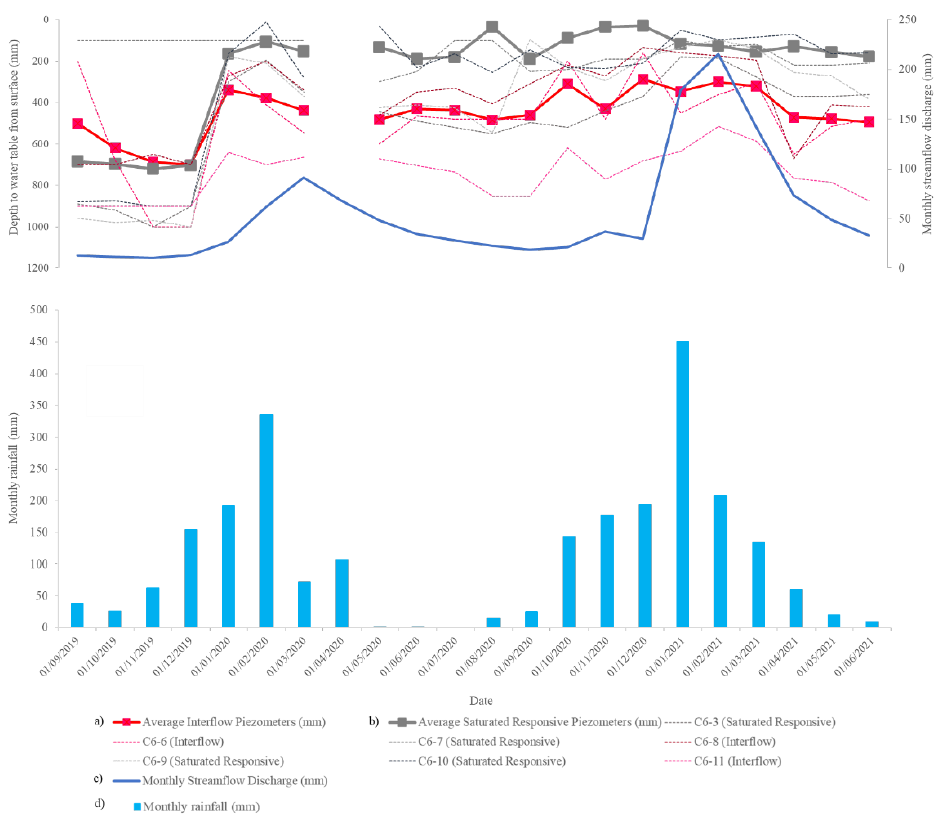
Figure 6. Comparisons of piezometer data installed in the ( a ) interflow soils, ( b ) saturated responsive soils, ( c ) monthly streamflow discharge and ( d ) monthly rainfall in CP-VI.